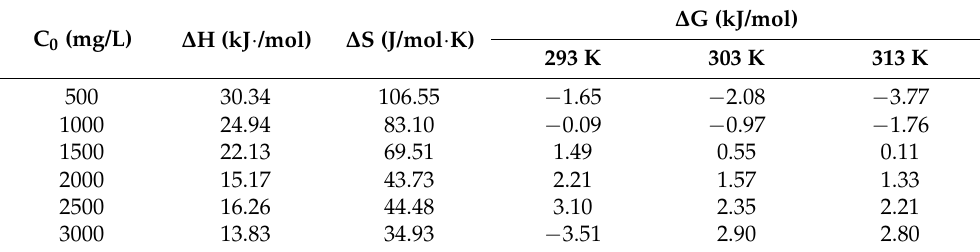
Table 5. Thermodynamic parameters of the adsorption EGCG on PILs. C 0